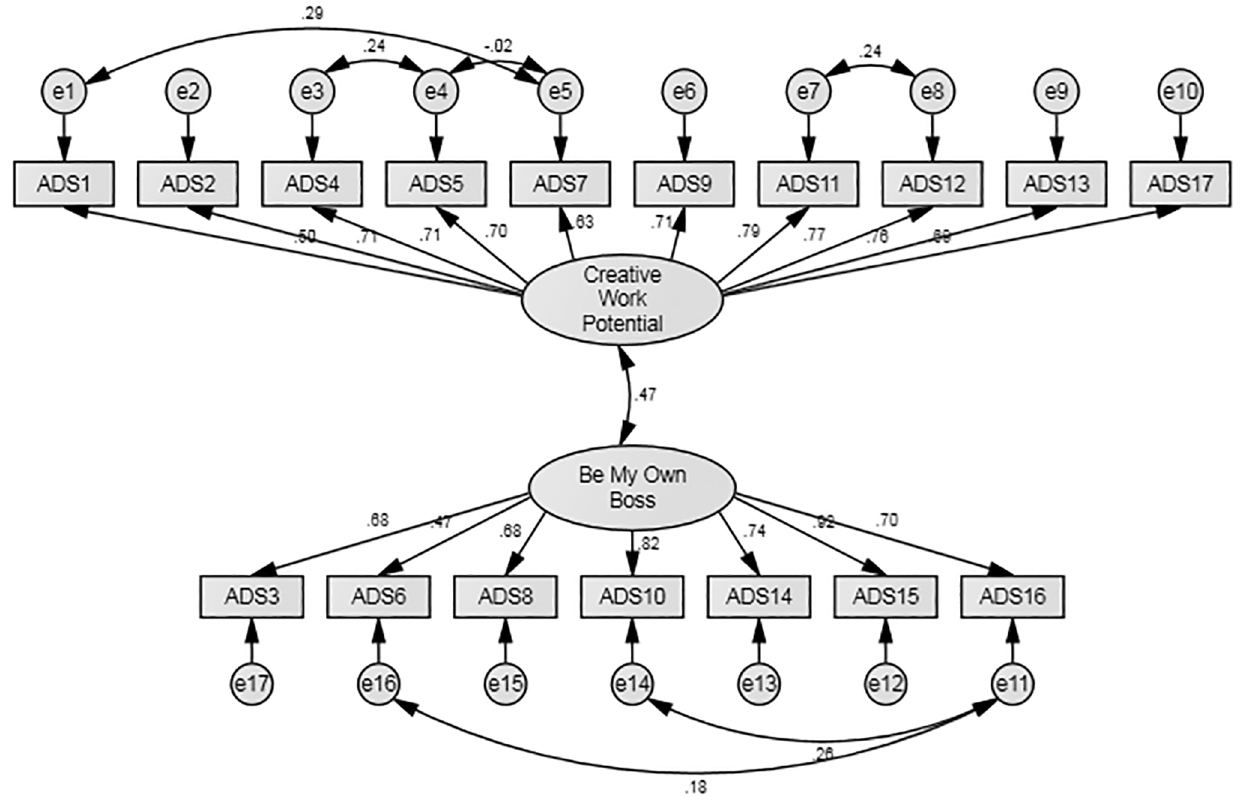
Figure 3. Confirmatory factor analysis (Study 3) of the ADS construct. Latent constructs are shown in ellipses, and observed variables are shown in